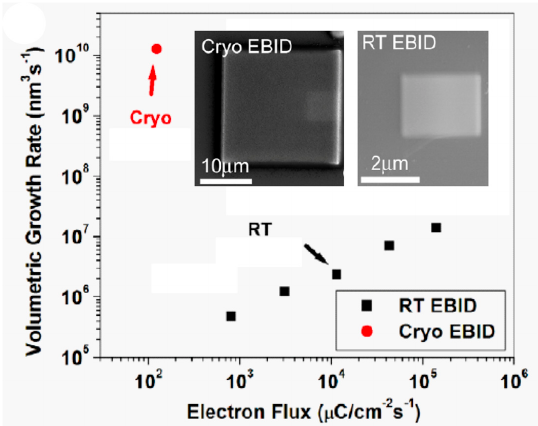
Figure 3. Growth rate enhancement of Pt-C deposits grown by Cryo-FEBID compared to those grown using RT FEBID. The inset shows SEM micrographs of the obtained deposits. Adapted and reprinted from Bresin et al., Nanotechnology 2013 [54].